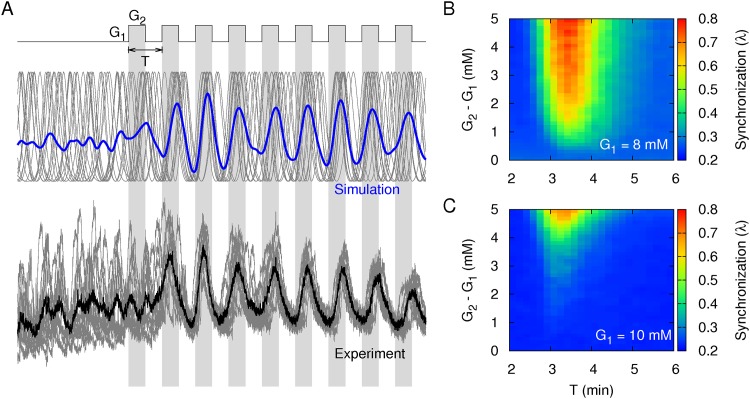
Synchronization of islet Ca2+ oscillations under alternating glucose stimuli.(A) Time traces of intracellular Ca2+ concentrations within each islet (gray lines) when the glucose concentrations alternated between G1 = 8 mM and G2 = 10 mM with a period of T = 4 min (Top: simulation, Bottom: experiment). The blue line represents the averaged time trace from n = 20 islets (simulation), while the black line represents the averaged time trace from n = 14 islets (experiment). Islets were initially loaded at 3 mM glucose. Before the glucose alternation, islets were equilibrated at 8 mM glucose for 30 min. (B) Synchronization index (λ) for various amplitudes (G2 –G1) and periods (T) of the glucose alternation given G1 = 8 mM. (C) Synchronization index with G1 = 10 mM.